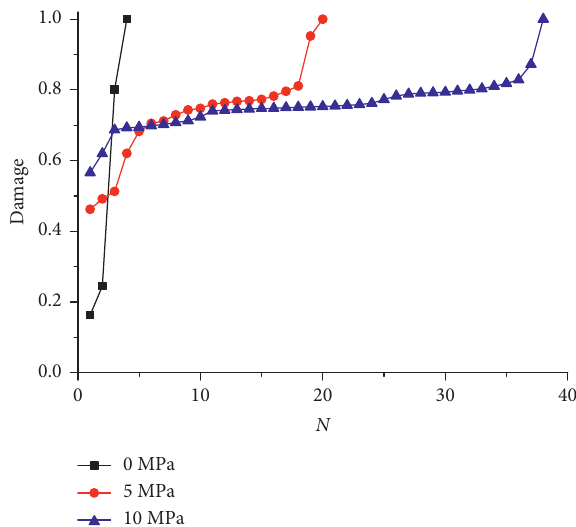
Figure 17: The damage curves of coal specimen subjected to cyclic loading at each cycle under the different confining pressures. Table 6: Contact number of specimen at the peak stress point of failure cycle under the different confining pressures. Scheme number Confining pressure (MPa) Number of fractured